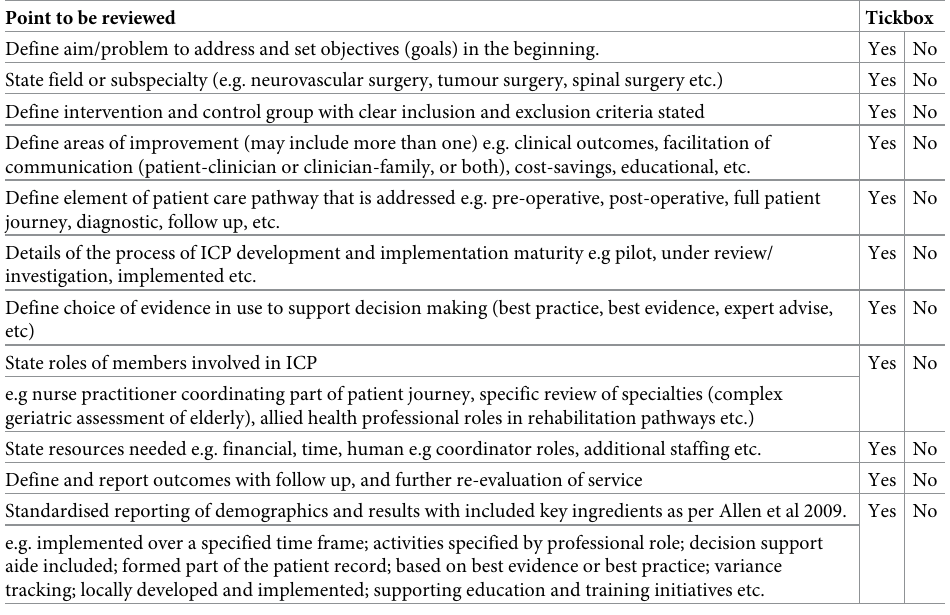
Table 3. ICP checklist regarding implementation, reporting and delivery. Point to be reviewed